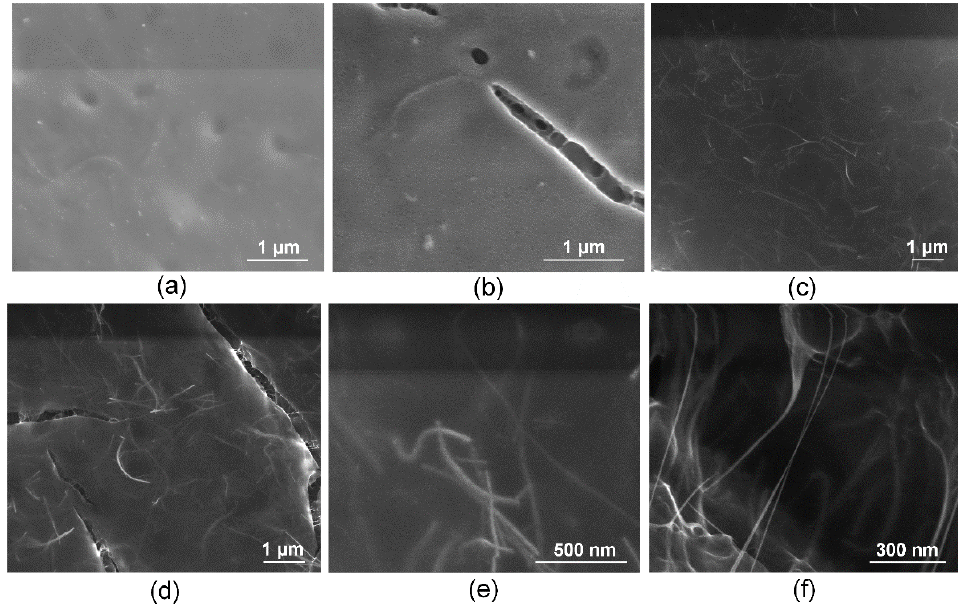
Figure 3. Scanning electron microscopy images of solder based on BSA (group 1) ( a ), BSA+ICG